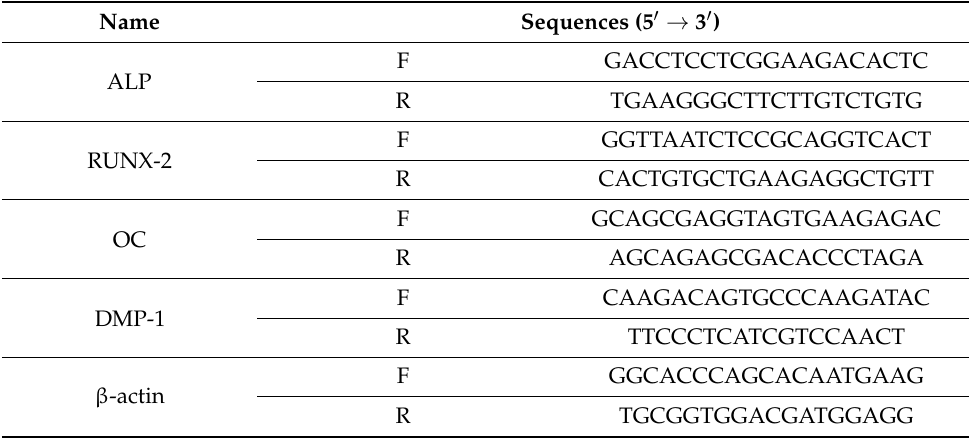
Table 1. Real-time PCR primer sequences.